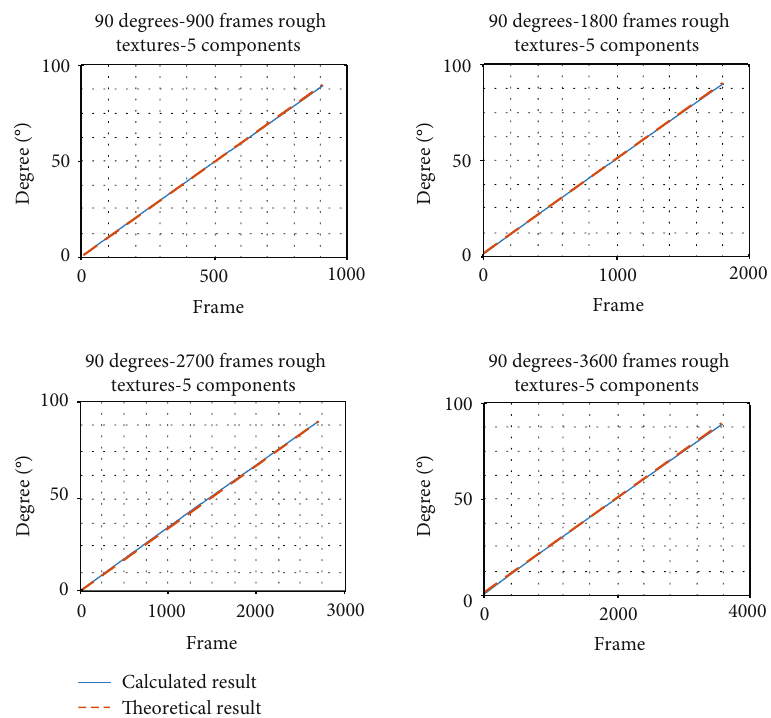
Figure 10: Angle estimation of model (c) under di ff erent imaging speeds (rotation angle of 90